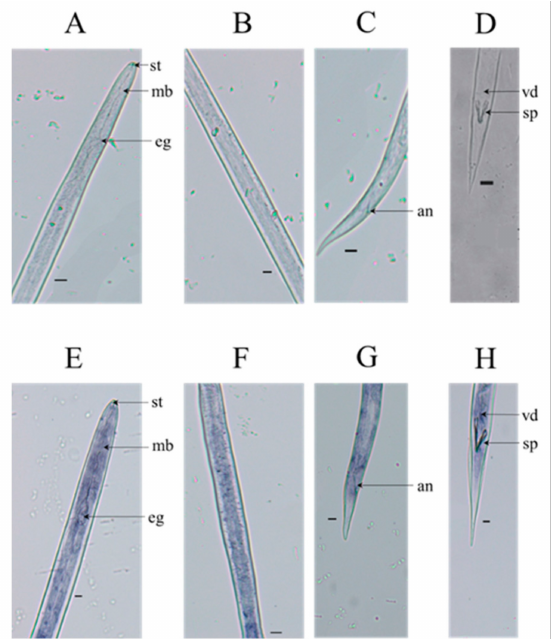
Figure 3. Localization of the expressed DdCa v β gene in D. destructor via in situ hybridization. ( A – D ) In situ hybridization of sense probes for DdCa v β in D. destructor . ( E – H ) In situ hybridization of antisense probes for DdCa v β in D. destructor . st: stylet; mb: median bulb; e.g., esophageal gland; an: anus; vd: vas deferens; sp: spicules. Scale bar = 20 µ m.